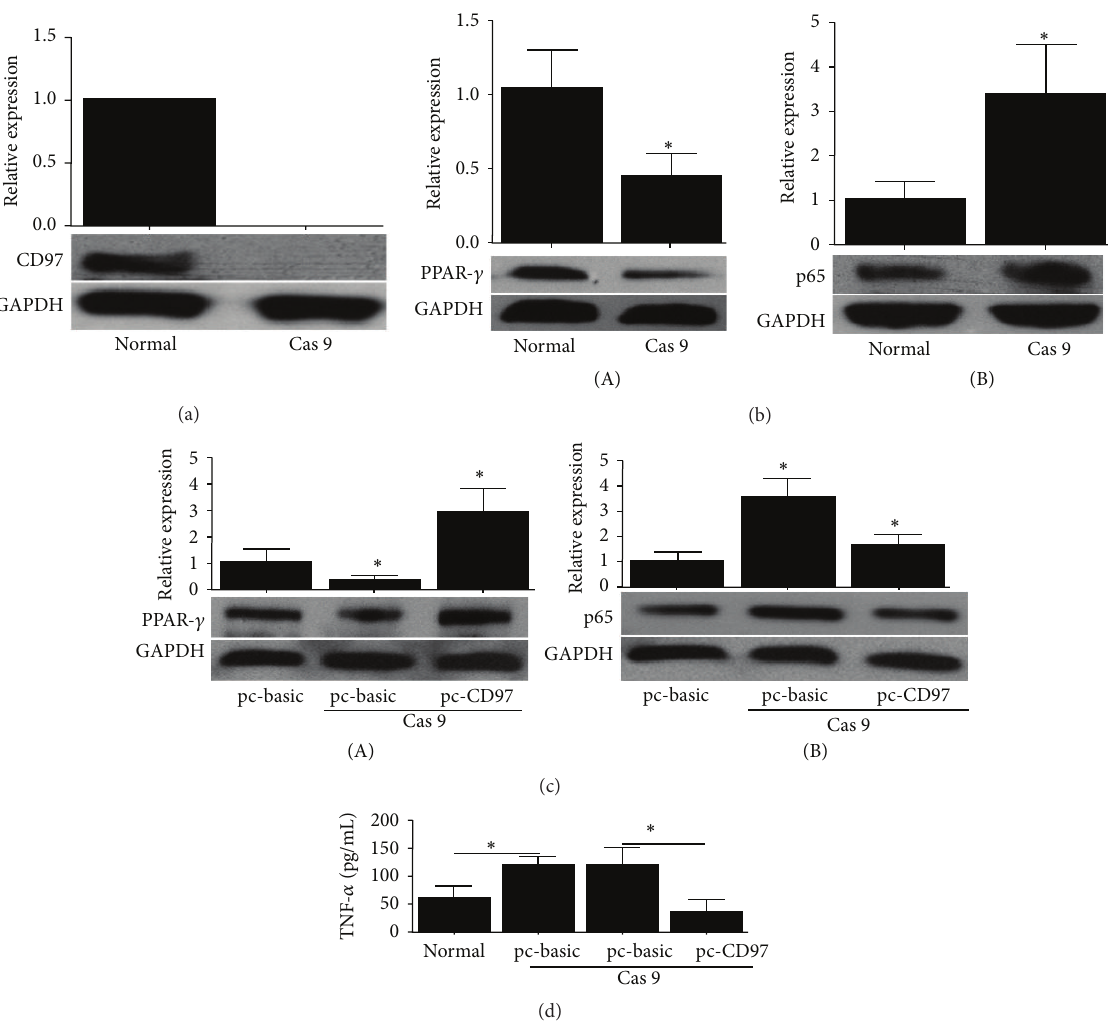
Figure 5: Effect of CD97 knockout on PPAR- 𝛾 and p65 expression in THP-1 cells. (a) Validation of CD97 knockout in THP-1 cells by CRISPR/Cas 9 system. (b) CD97 knockout inhibited PPAR- 𝛾 protein level (A), while it increased p65 expression (B). (c) CD97 ectopic expression in CD97 knockout THP-1 cells increased PPAR- 𝛾 protein level (A) while it inhibited p65 expression (B). (d) TNF- 𝛼 secretion was enhanced in CD97 knockout THP-1 cells while CD97 ectopic expression reversed this